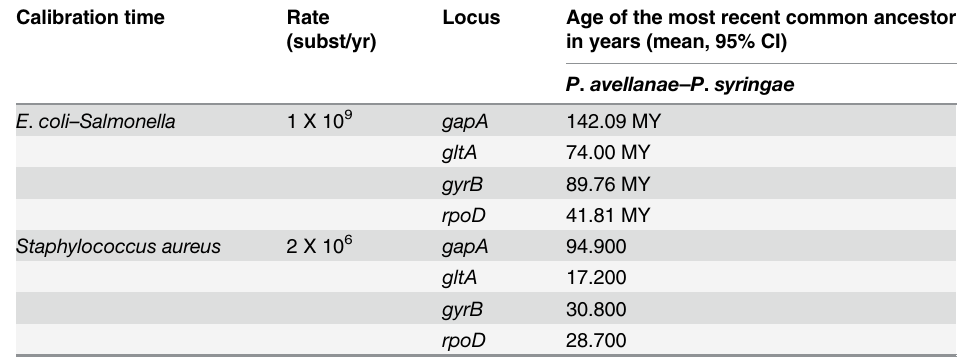
Table 4. Divergence time estimates between Pseudomonas avellanae and P . syringae pathovars avel- lanae , coryli and syringae strains infecting Corylus avellana trees, according to the Escherichia coli-